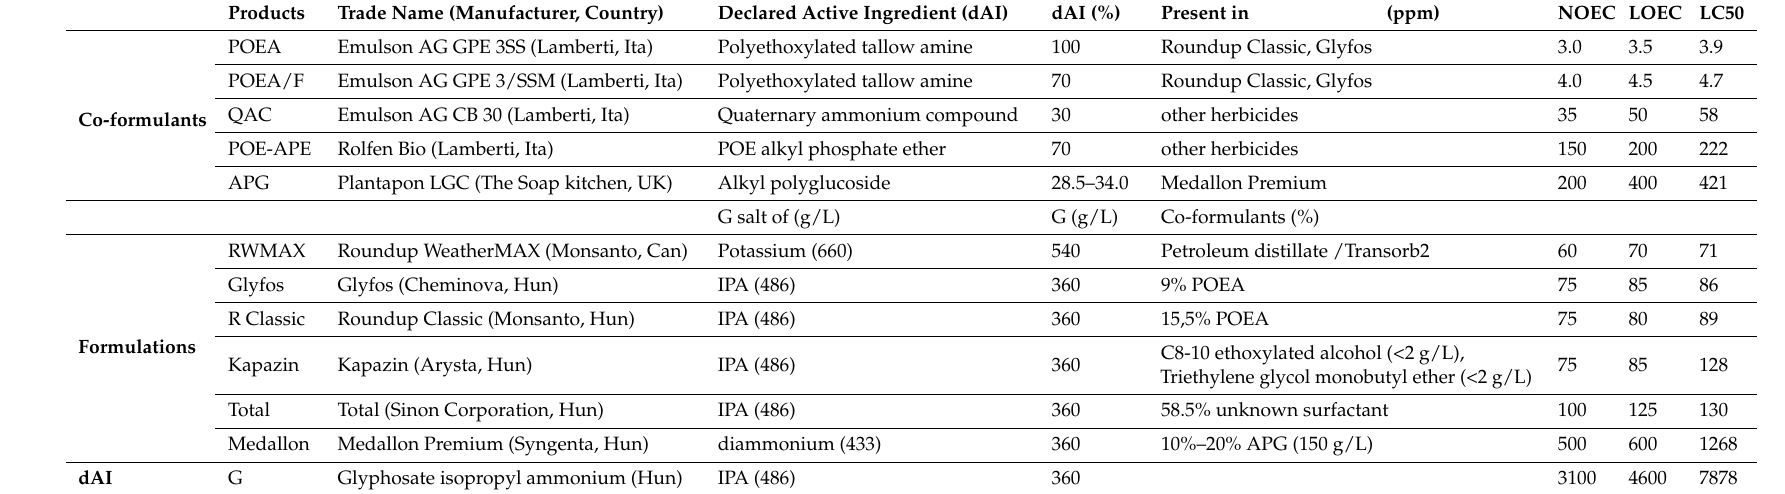
Table 1. Toxicological and chemical characteristics of the glyphosate-based herbicides (GBHs), the co-formulants, and the declared active ingredient (dAI) investigated in this study. Contents in co-formulants and glyphosate (type of salt and equivalent in glyphosate acid) are indicated for the GBH formulations. LC 50 (ppm) were calculated by nonlinear regression using asymmetric (5-parameters) equation with GraphPad Prism 5 after mitochondrial respiration inhibition measurement in JEG3 cells (MTT assay, see Figure 1). No Observed Effect Concentration (NOEC) and Lowest Observed Effect Concentration (LOEC, corresponding to the threshold of toxicity) were determined by MTT assay for each compound. They respectively correspond to the highest concentration without significant cytotoxic effect and to the lowest concentration with significant cytotoxic effect (in ppm). Can Canada, IPA isopropyl ammonium, G glyphosate, Hun